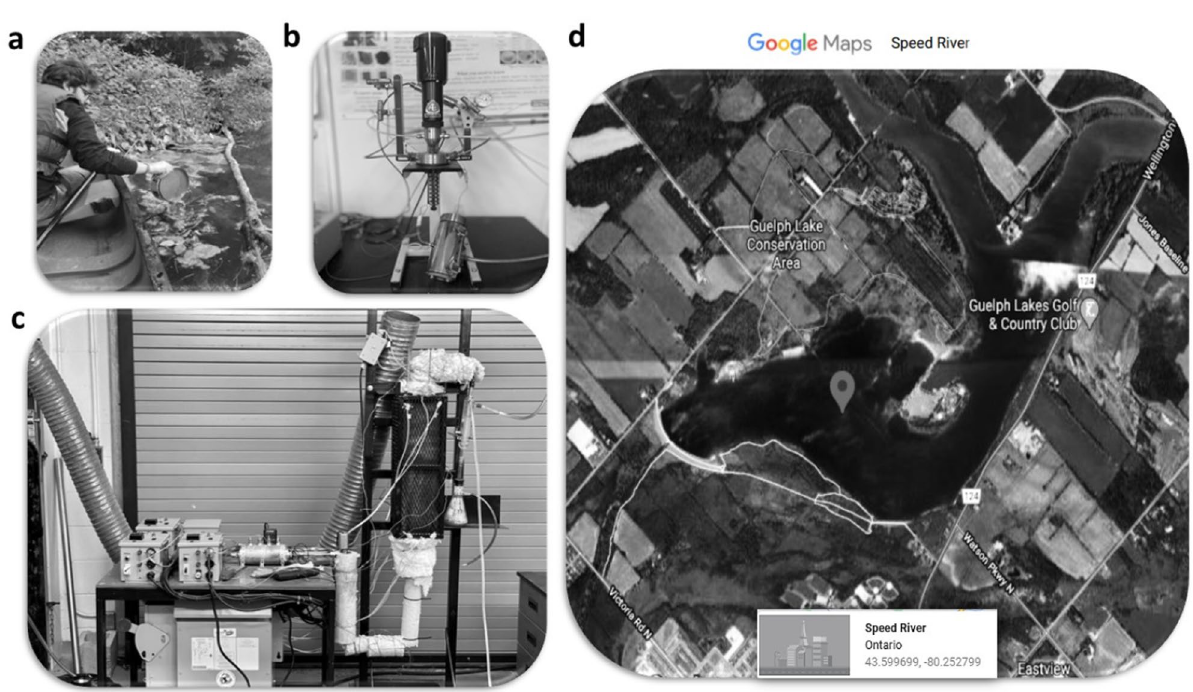
Figure 12. ( a ) physical location of sampling, schematics of the lab-scale experimental set up of the slow pyrolysis ( b ) and hydrothermal processes ( c ), and Satellite image ( d